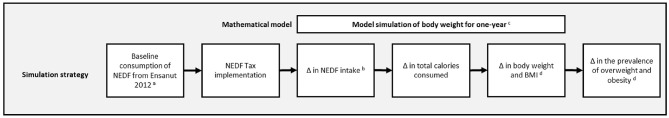
Schematic illustration of the 1-year simulation strategy to estimate the potential effect of the NEDF tax on BMI and the prevalence of overweight and obesity in children aged 6–17 years. aInputs for the model included Nonessential Energy-Dense Foods (NEDF) consumption, weight, and height, obtained from the 2012 Mexican National Health and Nutrition Survey (ENSANUT 2012) (16). bChange of NEDF consumption from ENSANUT 2012 was estimated at the individual level using an average of 5.1% reduction (15). cPredicted body weight 1 year after the NEDF tax was simulated using the Dynamic Childhood Growth and Obesity model (DCGO) from Hall et al. (17). dBody mass index (BMI) and BMI-z-scores 1 year after the NEDF tax were obtained using the World Health Organization reference to estimate prevalences of overweight and obesity in children (18). We assume that all the change in body weight occurs via reduction in NEDF consumption.